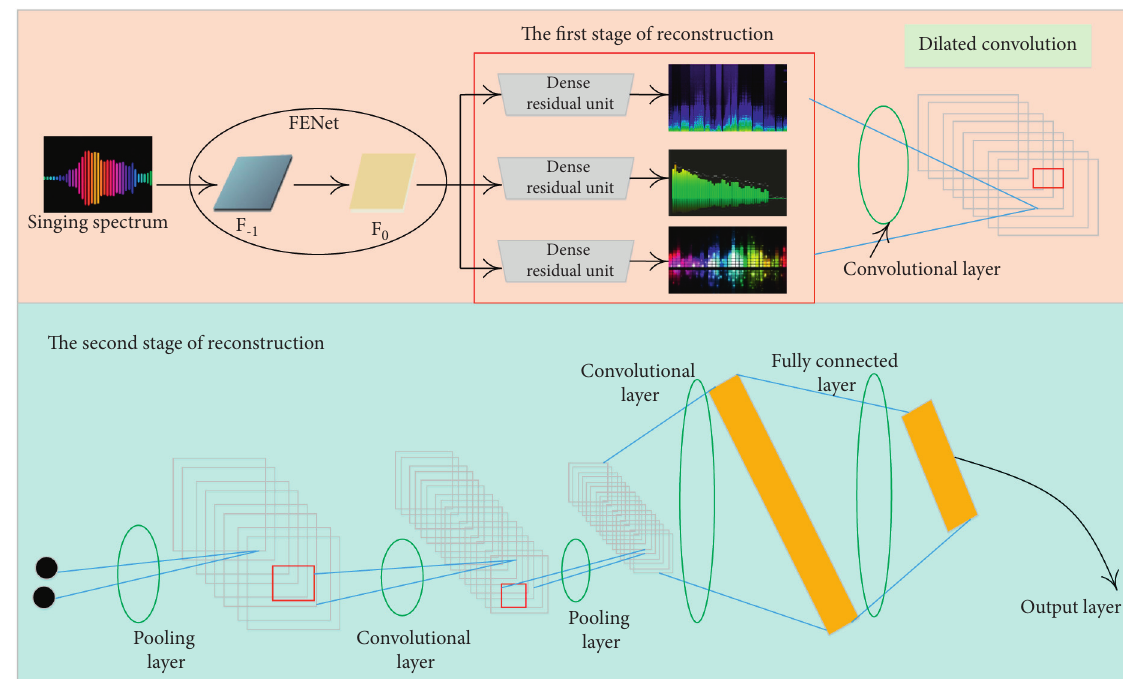
Figure 1: Two-stage super-resolution residual network framework